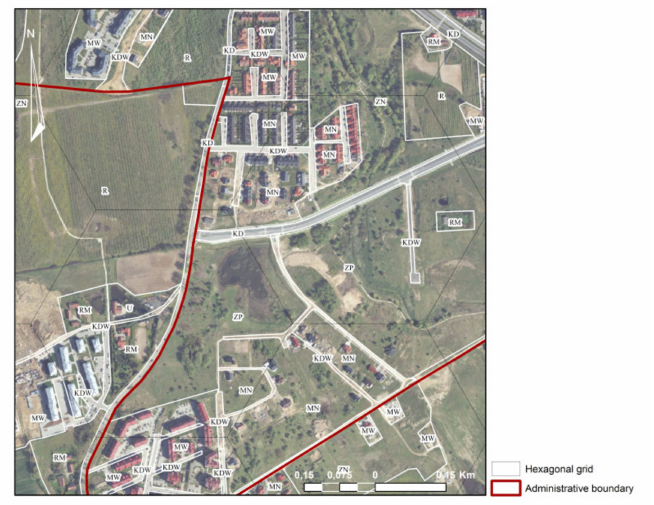
Figure 7. Inventory of the existing development—an example, 2017. Source: [20]. At present, orthophotomaps are produced with a field resolution of 10 cm, which allows the precise identification of objects. Orthophotomaps are successfully used as the creation of thematic